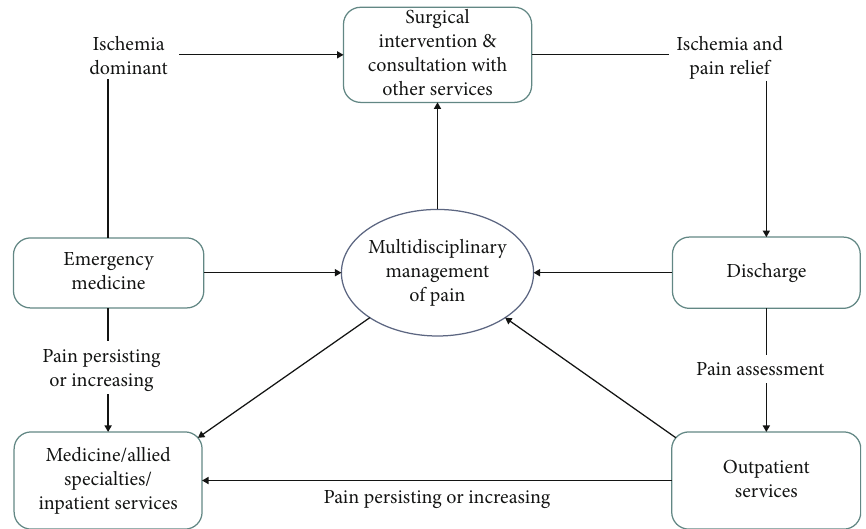
Figure 3: Management of ischemia pain with interdisciplinary